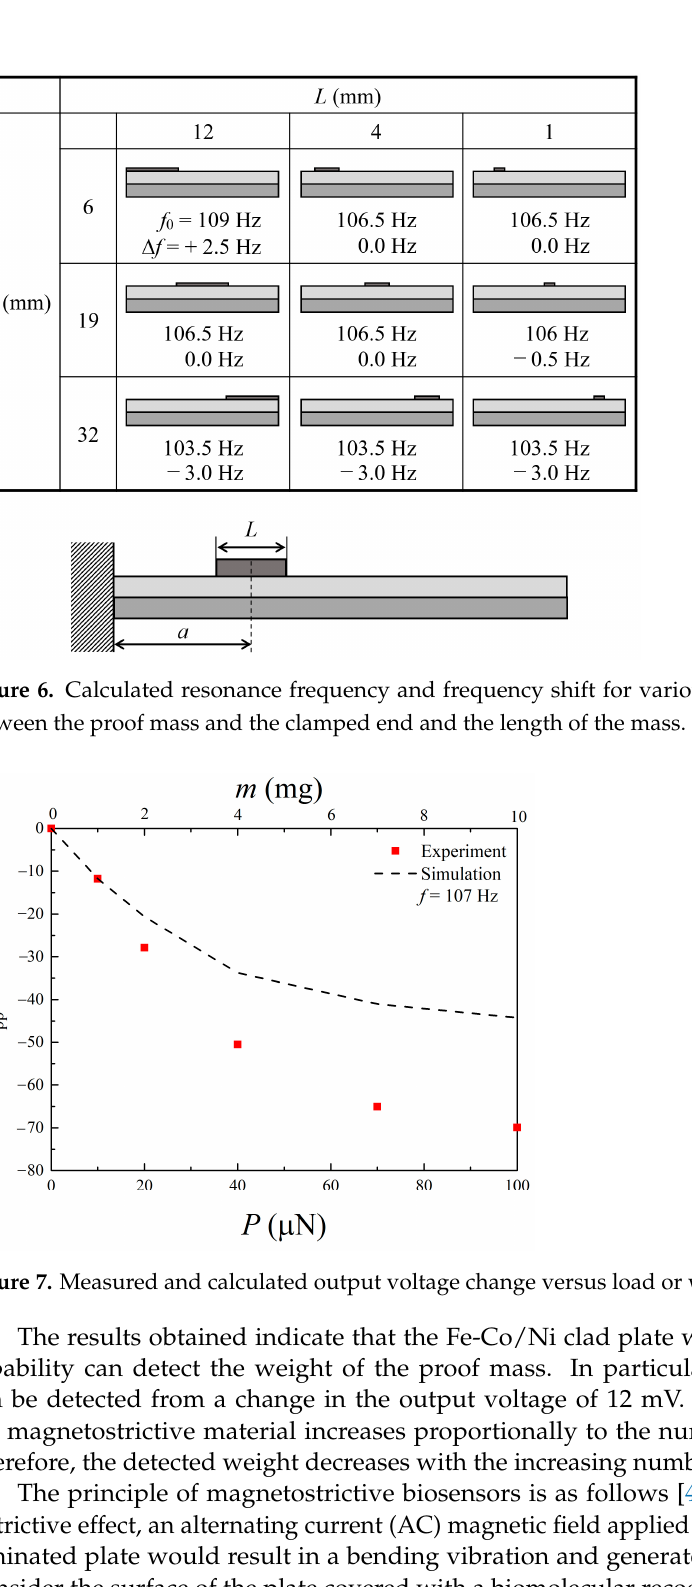
Figure 7. Measured and calculated output voltage change versus load or weight.